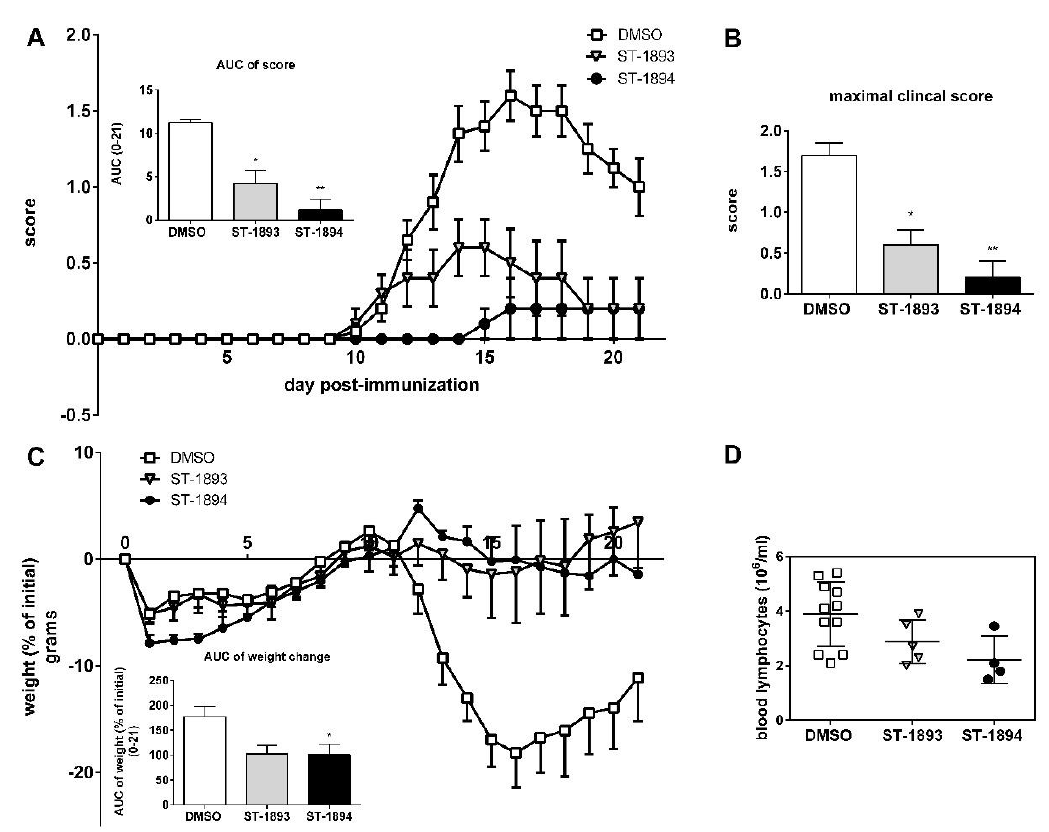
Figure 6. Effect of ST-1893 and ST-1894 on experimental antigen-induced encephalomyelitis (EAE) disease course. EAE was induced in C57BL/6J wt mice and, starting from day 5 until day 20 post immunization, they were injected with ST-1893, ST-1894, or DMSO dissolved in PBS at 5 mg/kg, as explained in Section 4. Graph in ( A ) represents the daily clinical score based on a four-point scoring system, and the inset graph presents the area under the curve (AUC) value from the scores from day 0 until day 21. The maximal clinical score reached for each individual mouse is presented in graph ( B ). Graph in ( C ) shows the weight change based on the weight at day 0 set as 0%, with the respective AUC calculation in inset. Results ( A – C ) are presented as means ± standard errors of the mean (SEM); * p < 0.05, ** p < 0.01, statistically significant when compared to the DMSO control EAE group ( n = 10, DMSO; n = 5, ST-1893; n = 5, ST-1894). ( D ) Blood was collected at day 21 in EDTA-K3-coated microvettes with cardiac puncture, and the number of lymphocytes per mL was measured as explained above and is presented as means ± SD ( n = 11, DMSO; n = 5, ST-1893; n = 4, ST-1894).